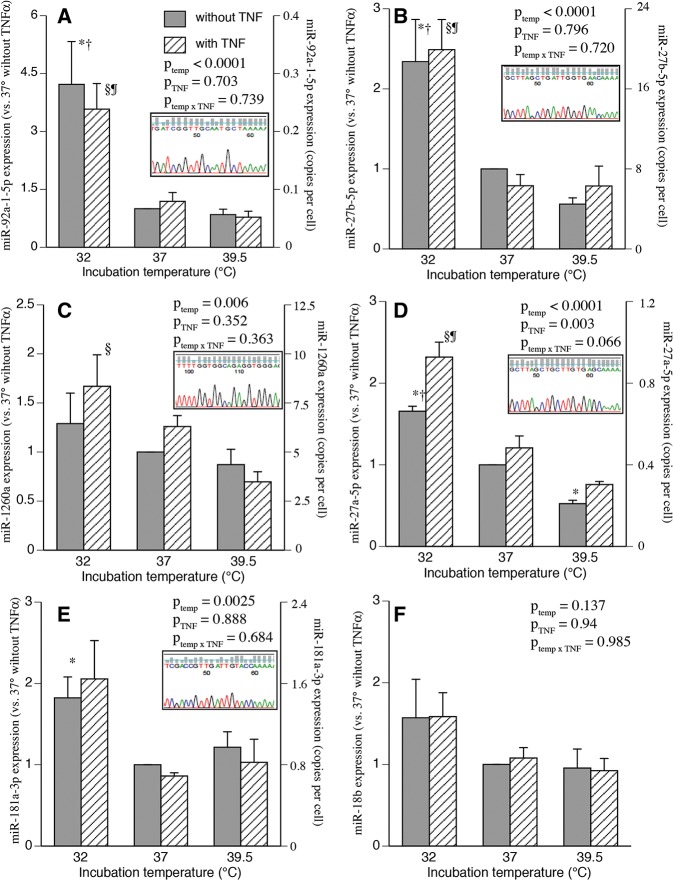
Quantitative RT-PCR confirmation of temperature effects on miRNA expression pattern in human SAECs. Human SAECs from two lots were incubated for 24 h at 32°C, 37°C, or 39.5°C without or with 1 ng/mL rhTNFα. Total RNA was collected and levels (A) hsa-miR-92a-1-5p, (B) hsa-miR-27b-5p, (C) hsa-miR-1260a, (D) hsa-miR-27a-5p, (E) hsa-miR-181a-3p, and (F) hsa-miR-18b were analyzed by qRT-PCR as described in Materials and Methods and expressed as a fold-change versus 37°C cells without TNFα. The right-hand axis displays the total expression level in copies per cell, which was calculated as described in Materials and Methods. Mean ± SEM. (*) P < 0.05 versus 37°C; (†) P < 0.05 versus 39.5°C; (§) P < 0.05 versus 37°C with TNFα; (¶) P < 0.05 versus 39.5°C with TNFα, n = 4. The temperature-responsive miRNAs were cloned into T-Vector and sequenced (inset).